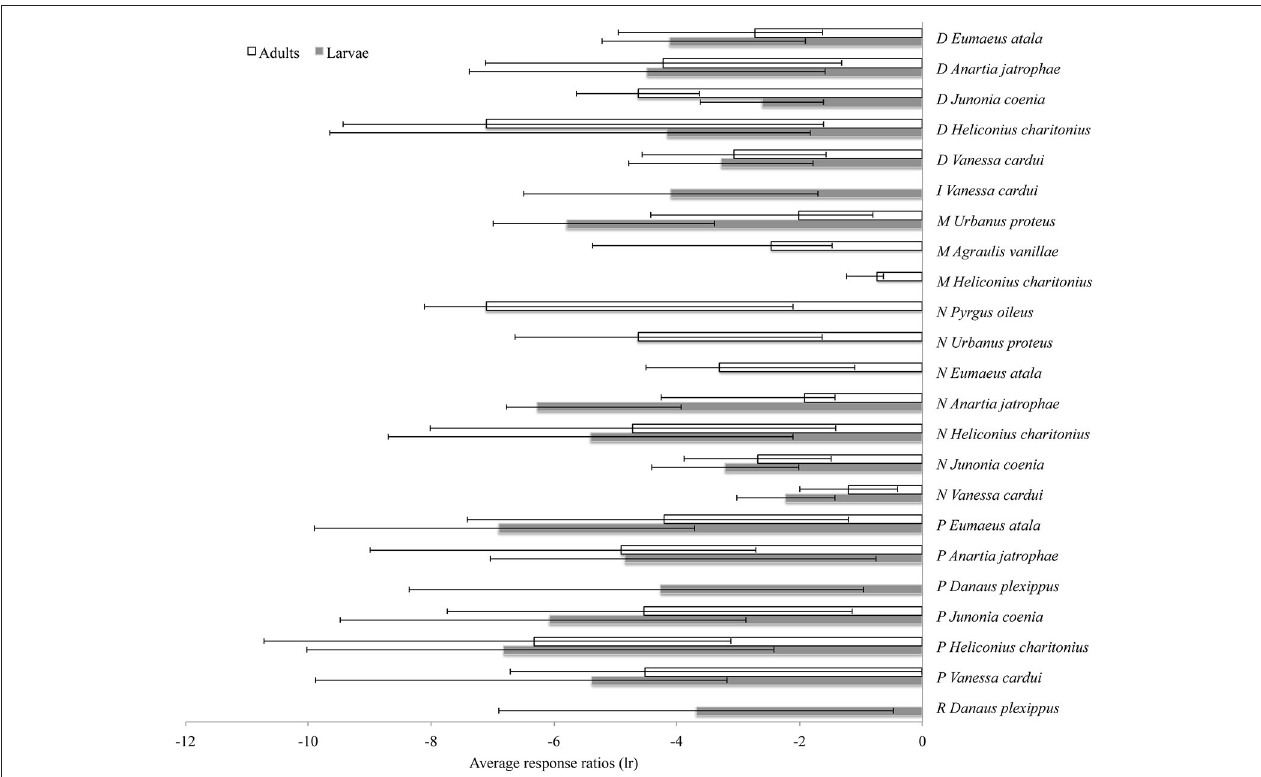
FIGURE 1 | The effect of insecticides (D, dichlorvos; I, imidacloprid; M, malathion; N, naled; P, permethrin; R, resmethrin) on larvae and adults of diurnal Lepidoptera, specimens are grouped in alphabetic order by family and then by species. Data are presented as average response ratios ( lr ) of treated-to-control group. The extremities of the bars indicates the minimum and maximum